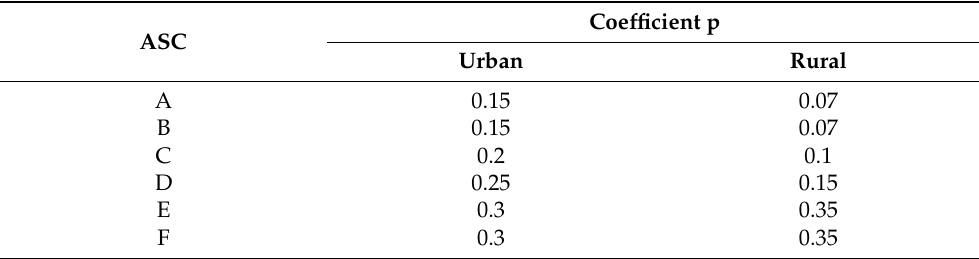
Table 4. Correction for wind